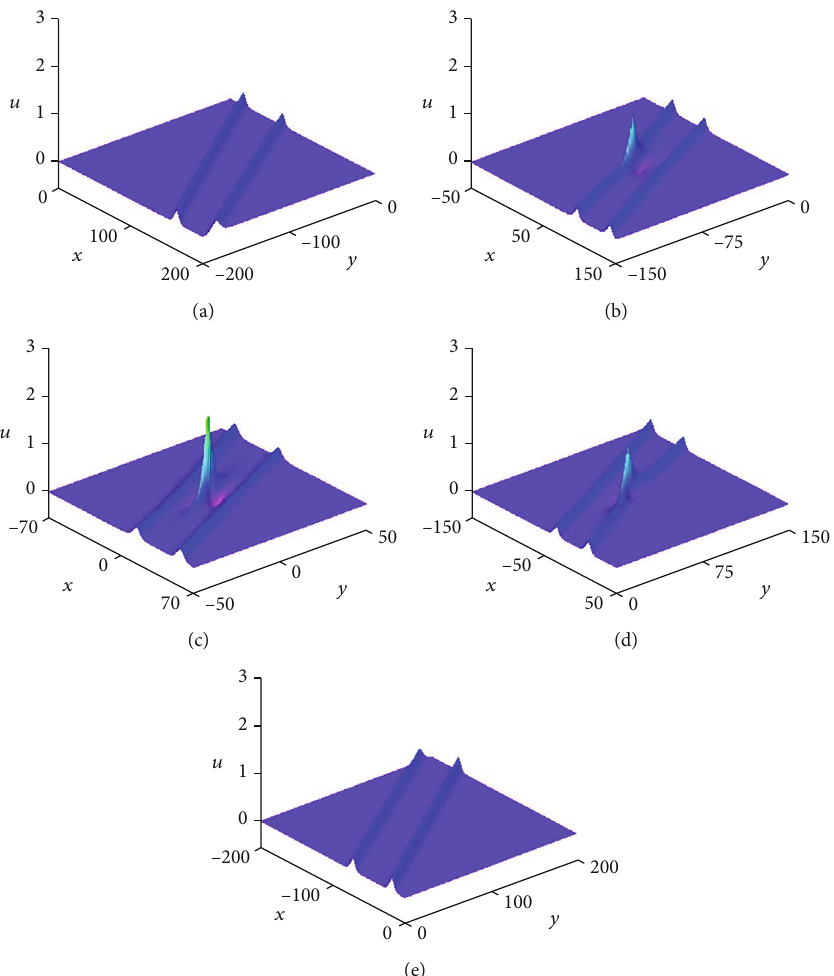
= 1/20 , a = 2 , k = l = 1/10 , a 1 5